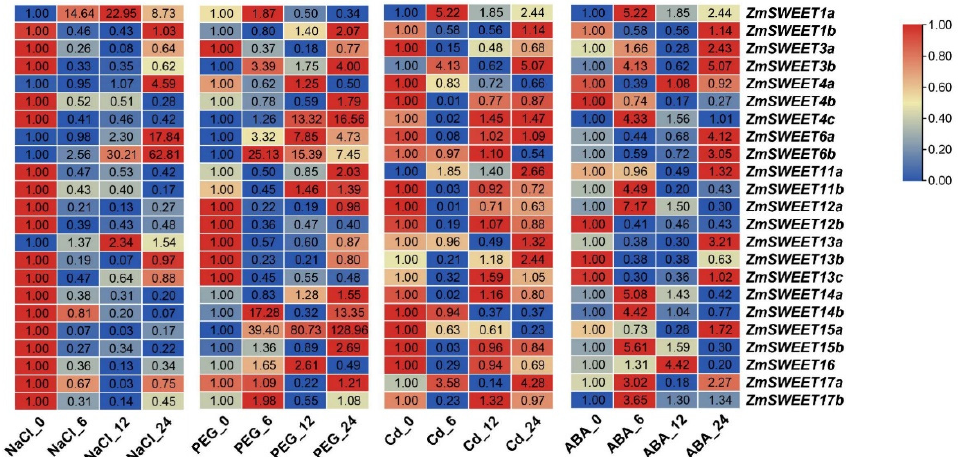
Figure 7. Expression analysis of ZmSWEET in response to abiotic stresses and exogenous ABA. Red represents induced expression; blue represents repressed expression. The 0 h relative expression level of each treatment was taken as 1.